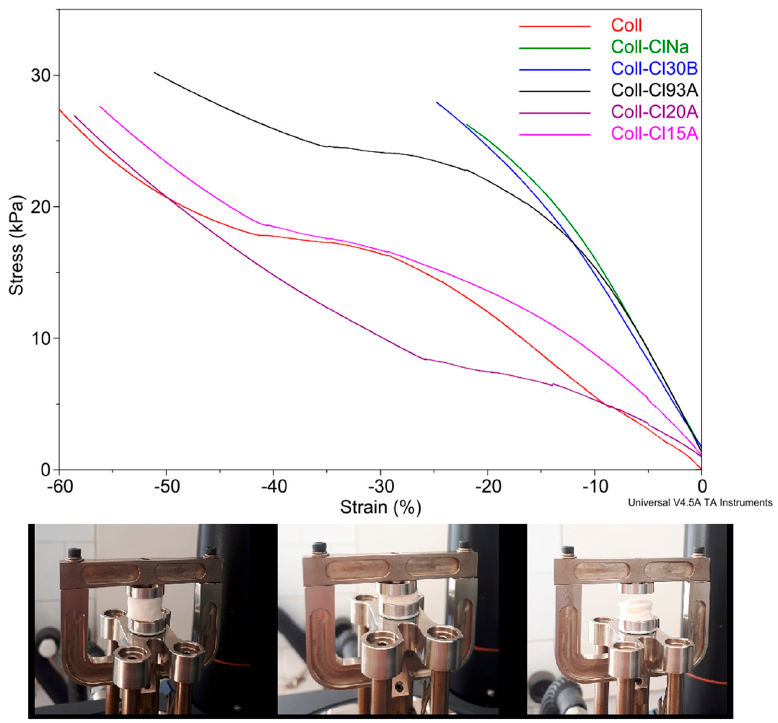
Figure 7. DMA mechanical properties of dried collagen/clay composite biomaterials.